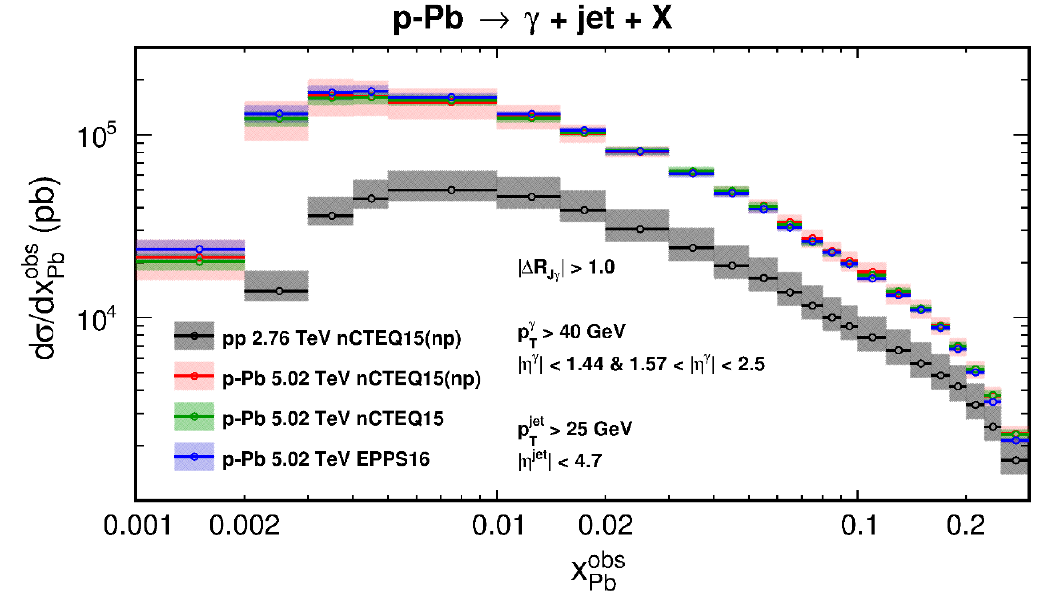
Figure 10 . Same as (cid:12)gure 9, but with larger acceptances in photon and jet rapidity, using endcap calorimeters, and lower threshold on the jet transverse